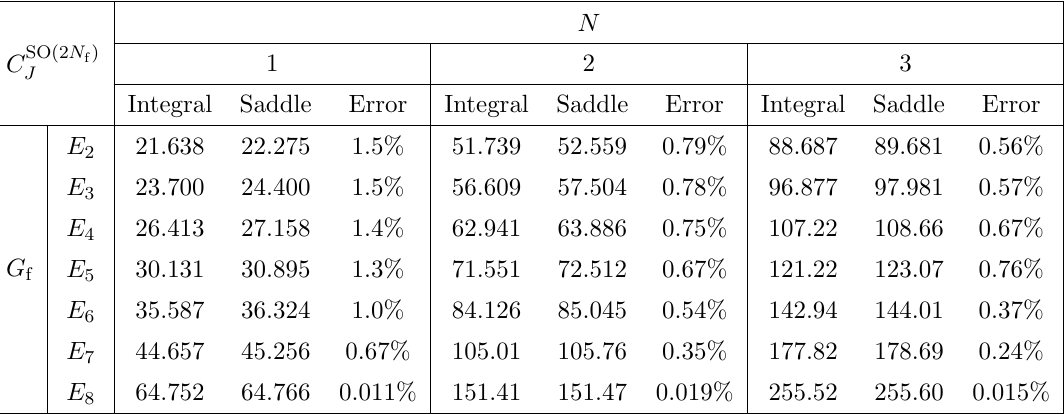
Table 5 . The perturbative values of the (cid:13)avor central charge C G f Seiberg theories, obtained using the hypermultiplet masses, computed by numerical integration and by the saddle point approximation.